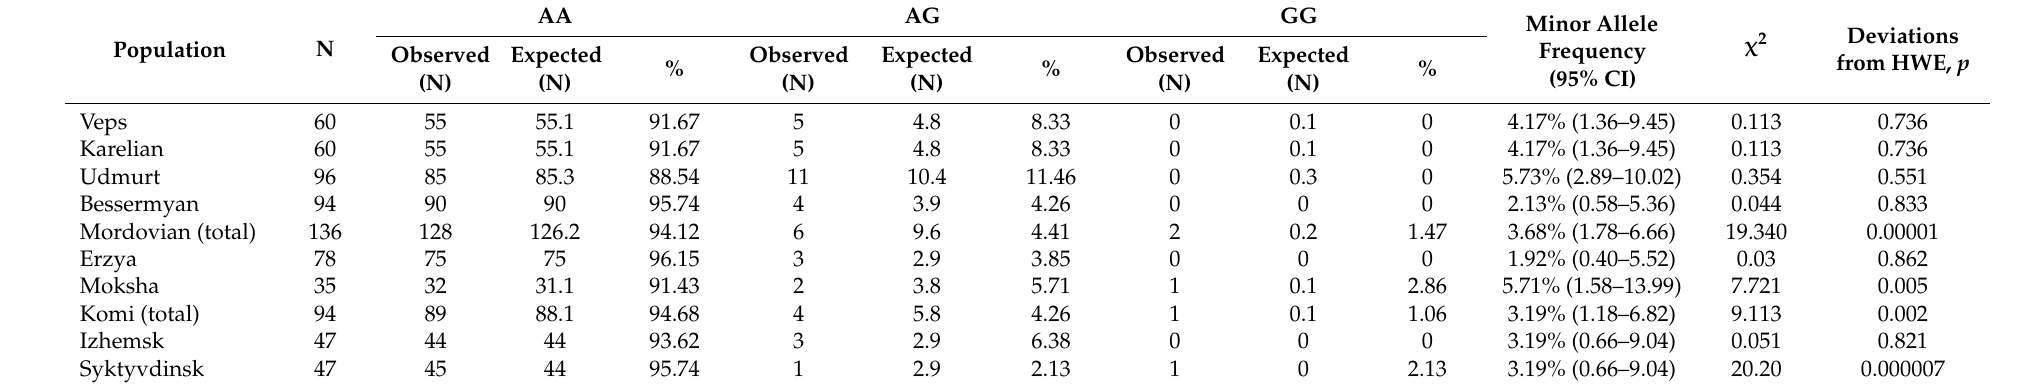
Table 2. Distribution of the rs1048943 genotypes of the CYP1A1 gene in the Finno-Permic populations of the Russian Federation.